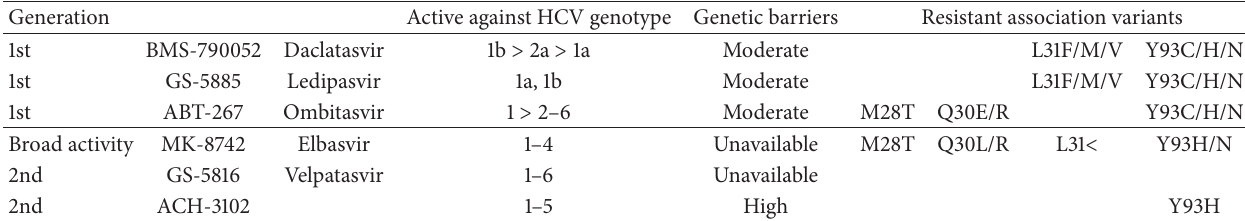
Table 2: Profile of NS5A